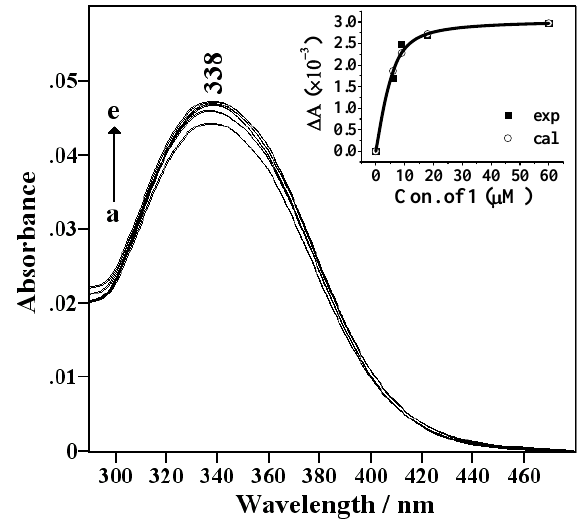
Figure 1. UV-Vis spectra of 3 in a phosphate buffer solution (6 μ M) in the presence or absence of 1 . The concentrations of 1 (from a to e) are 0, 6, 9, 18 and 60 μ M, respectively. Least-squares curve-fitting analysis (Inset) for the complexation of 3 with 1